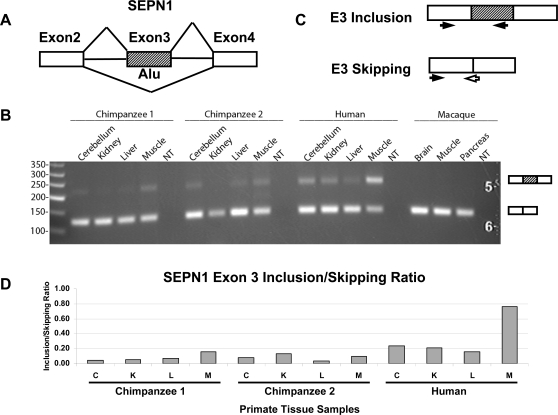
Evolution of SEPN1 Alu-exon splicing in primates.A. The splicing pattern of SEPN1 Alu-derived exon. B. RT-PCR analysis of the SEPN1 Alu-derived exon in human, chimpanzee and macaque tissues. The RT-PCR primer was designed from the upstream and downstream constitutive exon on the human gene and matched perfectly to chimpanzee and macaque transcripts. C. Realtime qPCR primers that specifically amplify exon inclusion and skipping forms. The reverse PCR primer for the skipping form was designed from the junction of upstream and downstream constitutive exons. These PCR primers perfectly matched both human and chimpanzee transcripts. D. The ratio of exon inclusion/skipping in human tissues and tissues of two chimpanzees estimated by realtime qPCR. The SEPN1 exon showed strong exon inclusion in human muscle but not in chimpanzee muscle. C, cerebellum; K, kidney; L, liver; M, muscle.